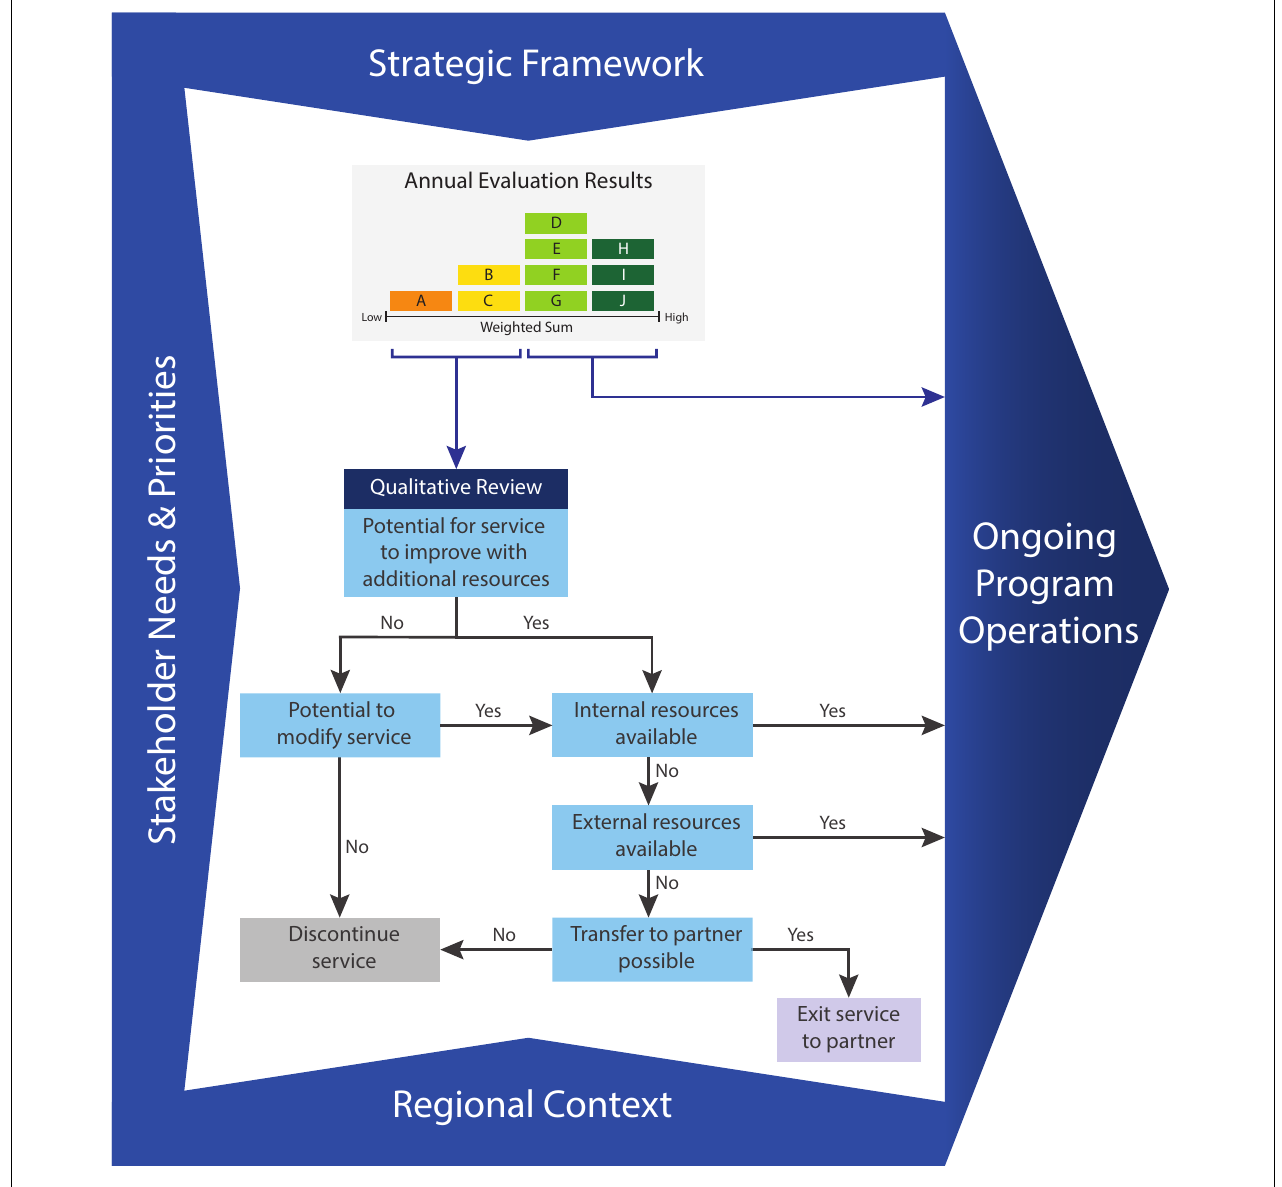
FIGURE 1 | Decision-making process diagram for consideration of annual service evaluation